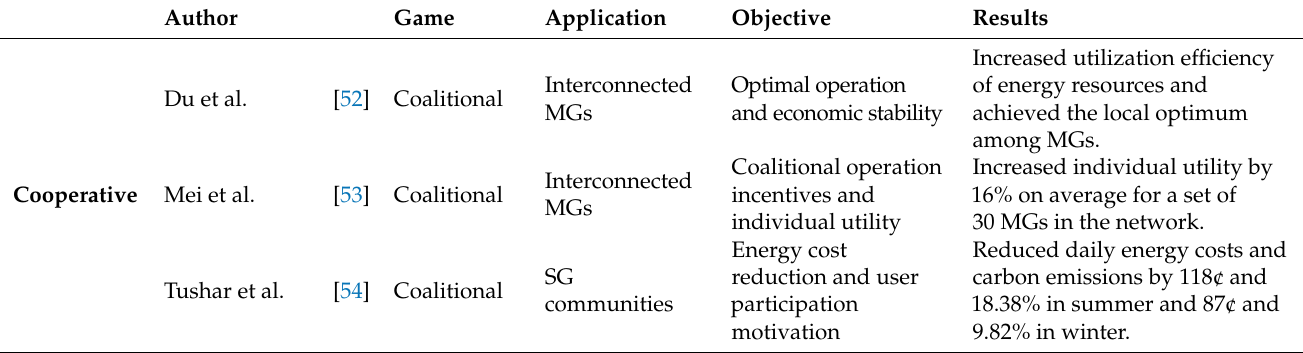
Table 4. Relevant works on P2P energy trading in SG and MG systems using game